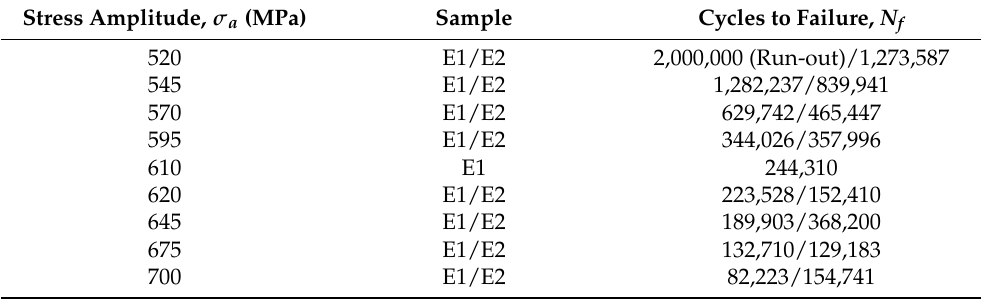
Table 3. Fatigue testing results with various stress amplitudes (note for 610 MPa, only E1 was tested). Stress Amplitude, σ a (MPa)